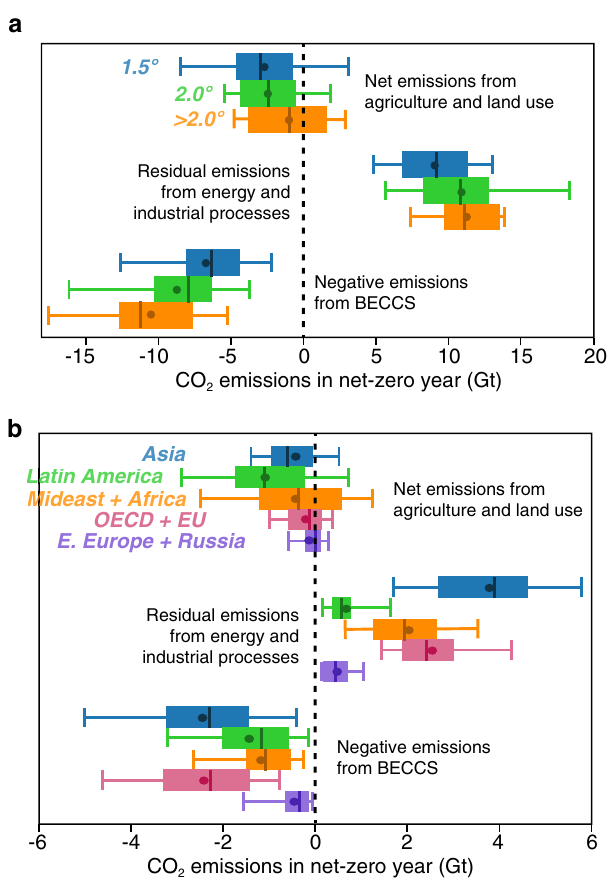
Fig. 3 Residual and negative emissions when global emissions reach net- zero. Residual and negative emissions in net-zero scenarios show global differences across different warming levels ( a ) and regions ( b ). In each case, the boxes show the range from 25 th to 75 th percentiles, whiskers show the 5 th and 95 th percentiles, and the lines and circles within the boxes denote the median and mean values, respectively.